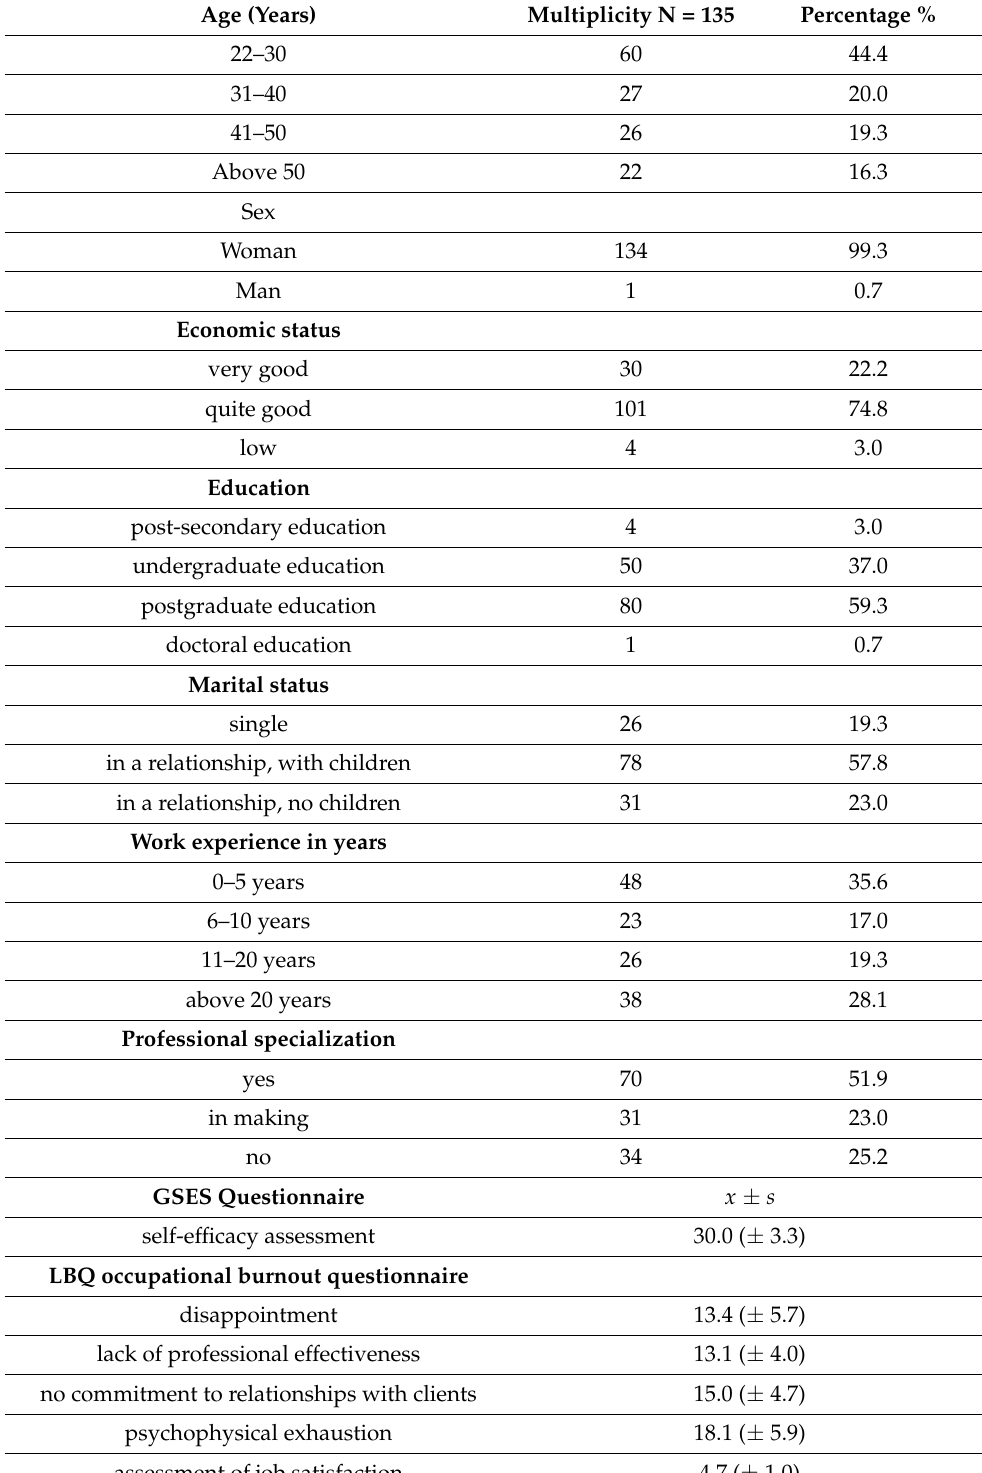
Table 1. General characteristics of the surveyed